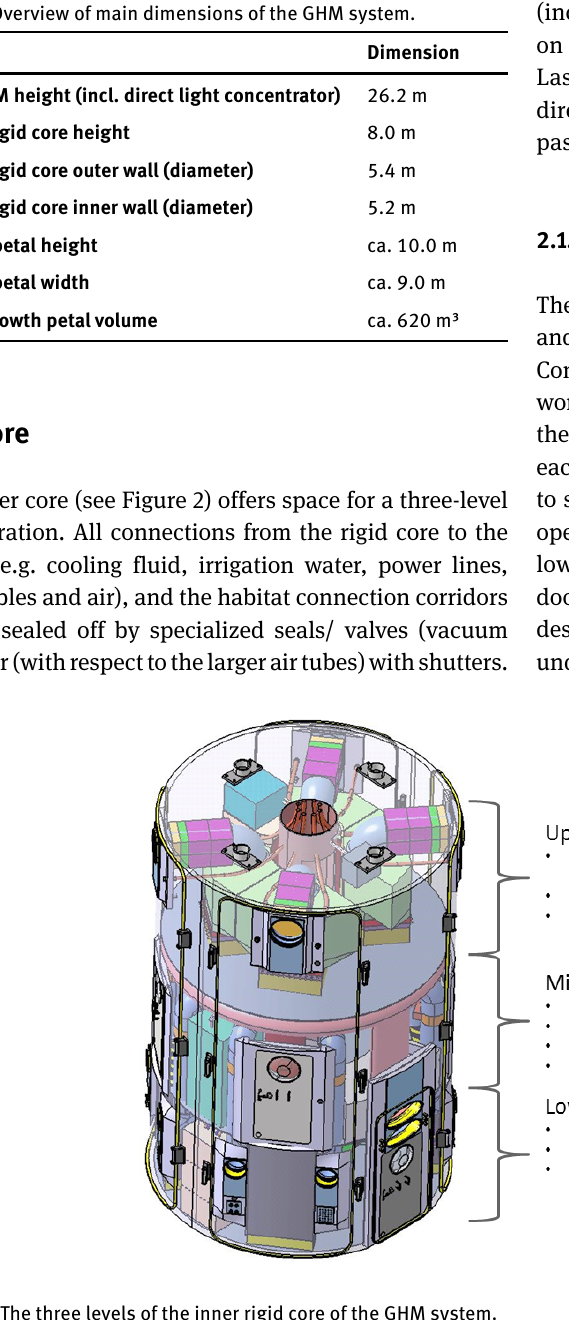
Figure 2: The three levels of the inner rigid core of the GHM